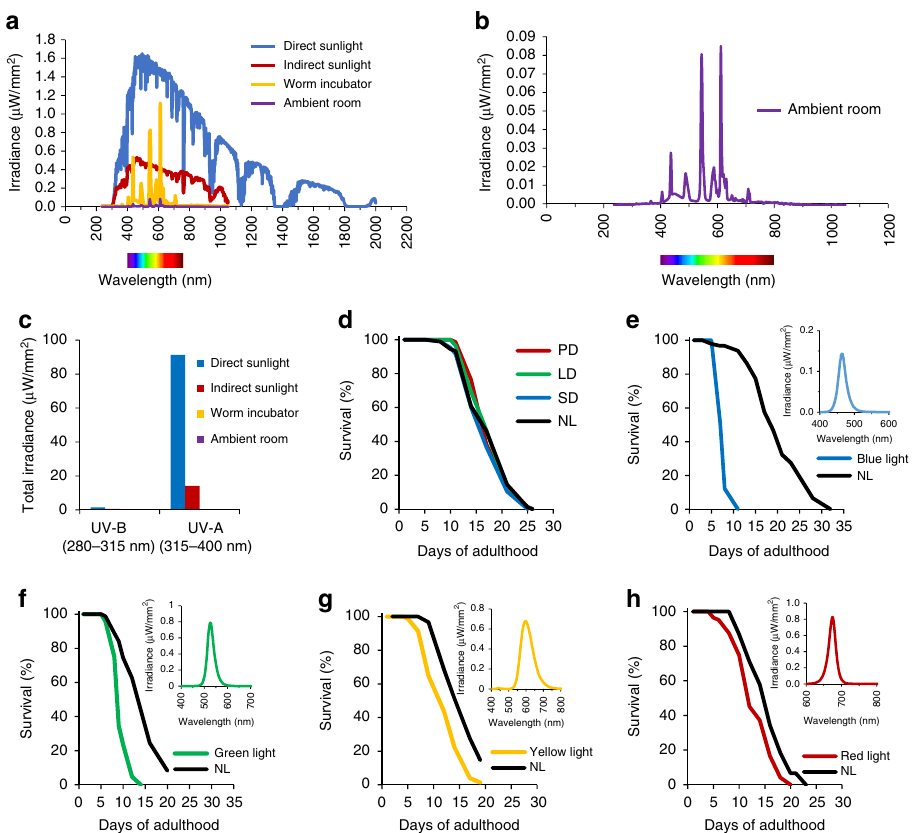
Fig. 4 Worm lifespan is inversely proportional to wavelength energy. a Irradiance spectrum of the sun under direct or indirect sunlight, compared to the spectrum of white fl uorescent tubes used in incubators and the laboratory (ambient room). b Detailed irradiance spectrum of white fl uorescent tubes used in the laboratory (ambient room). c Total irradiance of UV light emitted by fl uorescent white light versus solar radiation. d Lifespan under dark conditions of progeny derived from adult worms exposed to different photoperiods. e Lifespan of worms exposed permanently to blue, ( f ) green, ( g ) yellow, or ( h ) red LED light compared to controls kept in NL condition. Insets represent the spectrum of each color-speci fi c